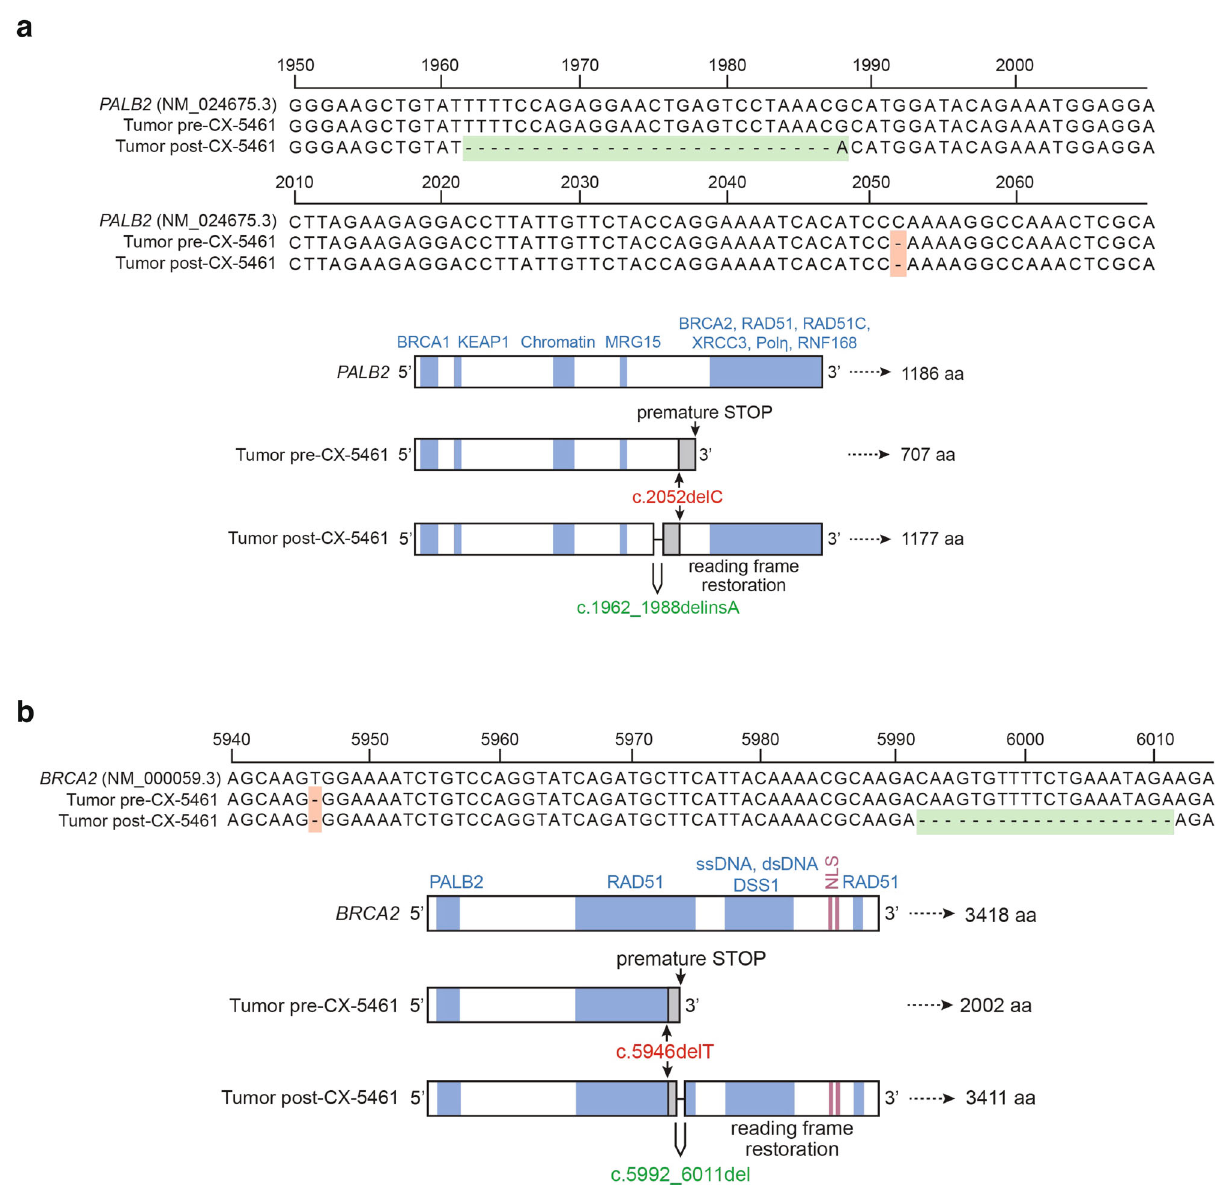
Fig. 4 Post-progression reversion mutations. a gPALB2 patient. Sequence alignment from the PALB2 locus comparing pre- (top) and post-treatment (bottom) sequence in a responding patient (con fi rmed PR) with gPALB2 -related breast cancer. Germline alteration is shown in red, and upstream acquired somatic deletion is shown in green (upper panel). The secondary mutation is predicted to restore a near full-length PALB2 protein (lower panel). b gBRCA2 patient. Sequence alignment from the BRCA2 locus comparing pre- (top) and post-treatment (bottom) sequence in a patient with gBRCA2 -related pancreatic cancer, who experienced clinical bene fi t (best response SD; 13% shrinkage in target lesions, with improvement in tumor markers and disease- related symptoms), followed by progression. Germline alteration is shown in red, and downstream acquired somatic deletion is shown in green (upper panel). The secondary mutation is predicted to restore a near full-length BRCA2 protein (lower